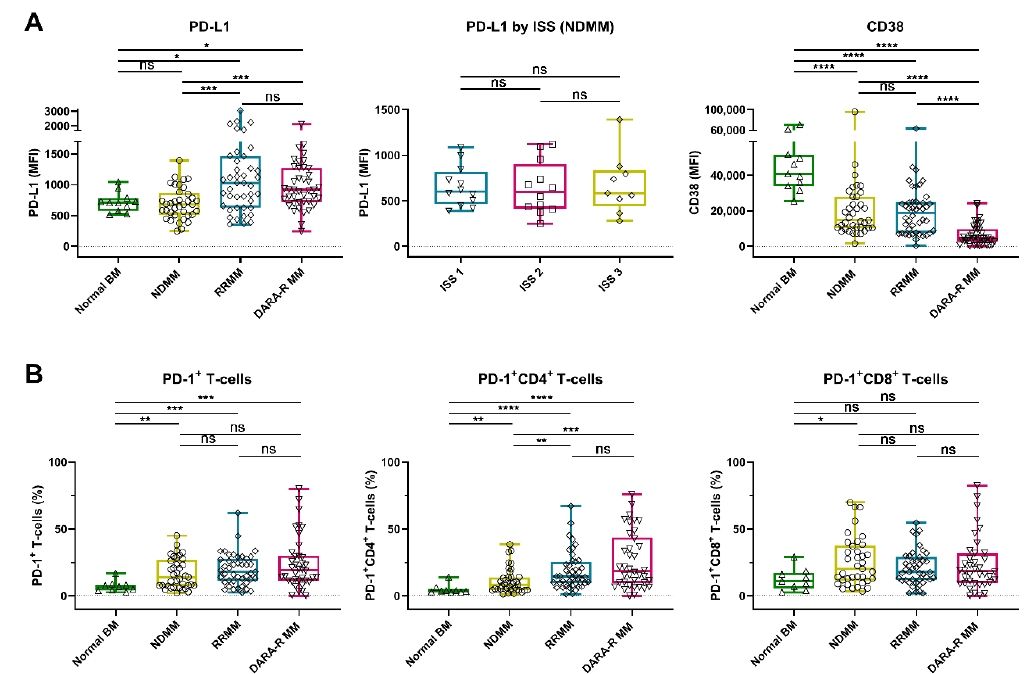
Figure 1. Expression of PD-L1 and CD38 on tumor cells and frequency of PD-1 + T-cells in BM samples from healthy controls and MM patients. ( A ) Expression levels (MFI) of PD-L1 and CD38 on normal plasma cells ( n = 11) and MM cells (NDMM ( n = 37), daratumumab-naïve RRMM ( n = 43), and daratumumab-refractory MM ( n = 41)) are depicted. For newly diagnosed patients, PD-L1 is given per ISS stage. ( B ) The proportions of PD-1 + T-cells, PD-1 + CD4 + T-cells, and PD-1 + CD8 + T-cells are shown per category (normal BM ( n = 9), NDMM ( n = 37), daratumumab-naïve RRMM ( n = 43), anddaratumumab-refractoryMM( n = 38)). Dataaredepictedasindividualpointswithboxandwhiskers, indicating the median, quartiles, and range. Indicated groups were compared using Mann–Whitney tests. Abbreviations: BM, bone marrow; MM, multiple myeloma; MFI, median fluorescence intensity; NDMM, newly diagnosed MM; RRMM, relapsed / refractory MM; ISS, International Staging System; ns, not significant; * p ≤ 0.05; ** p ≤ 0.01; *** p ≤ 0.001; **** p ≤